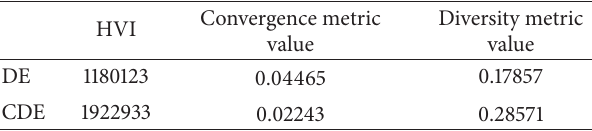
Table 7: The HVI, convergence, and diversity values produced by